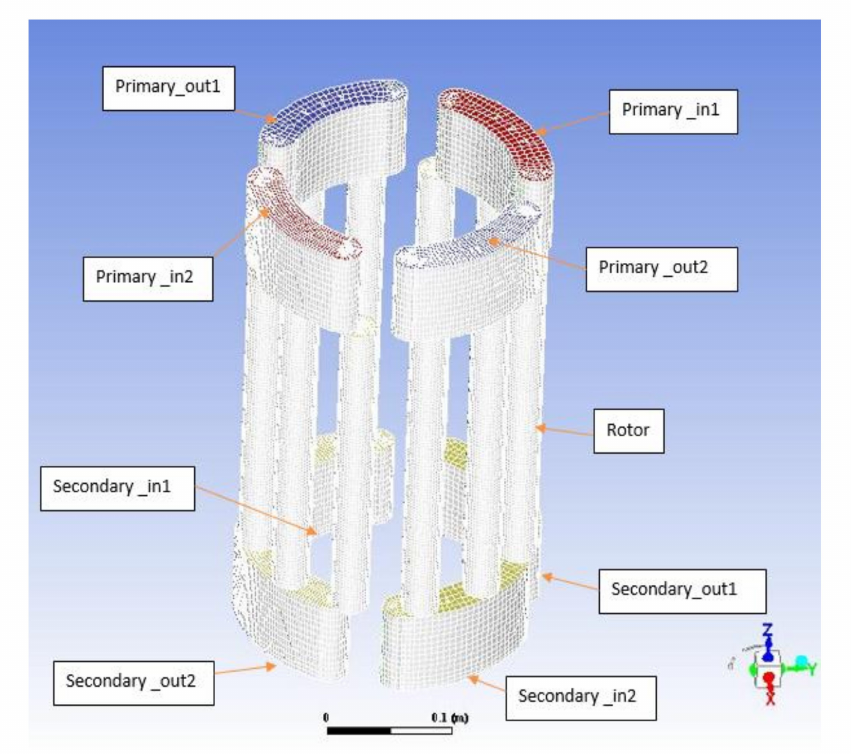
Figure 2. 3D CAD model of PX and generated